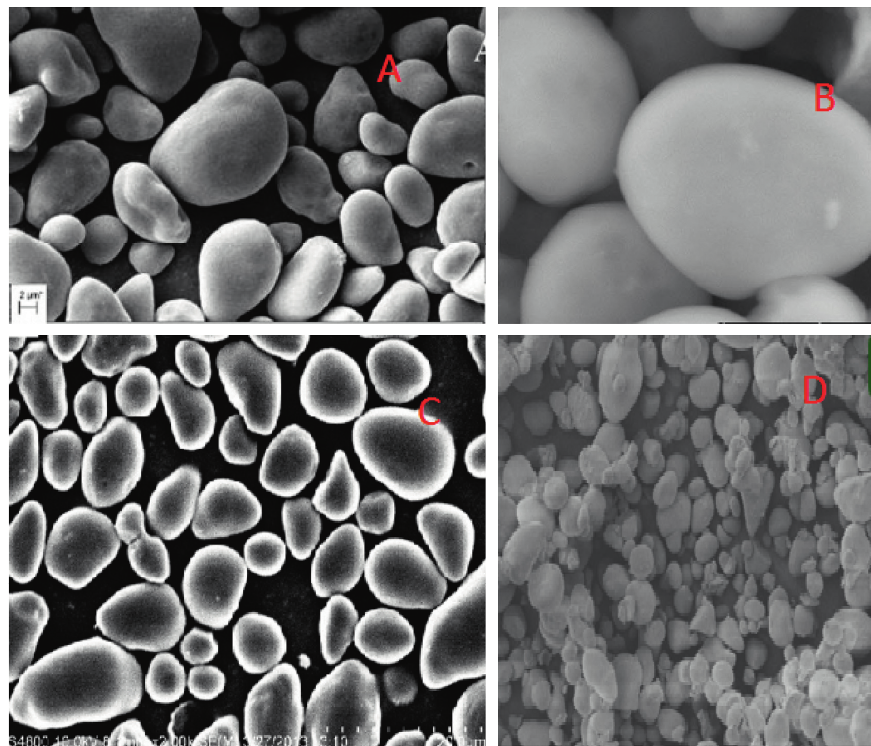
Figure 1: Selected SEM images of acorn starch. (a) Molavi et al. [25]. (b) Boukhelkhal and Moulai-Mostefa [20]. (c) Li et al. [7]. (d) Deng et al. [26].